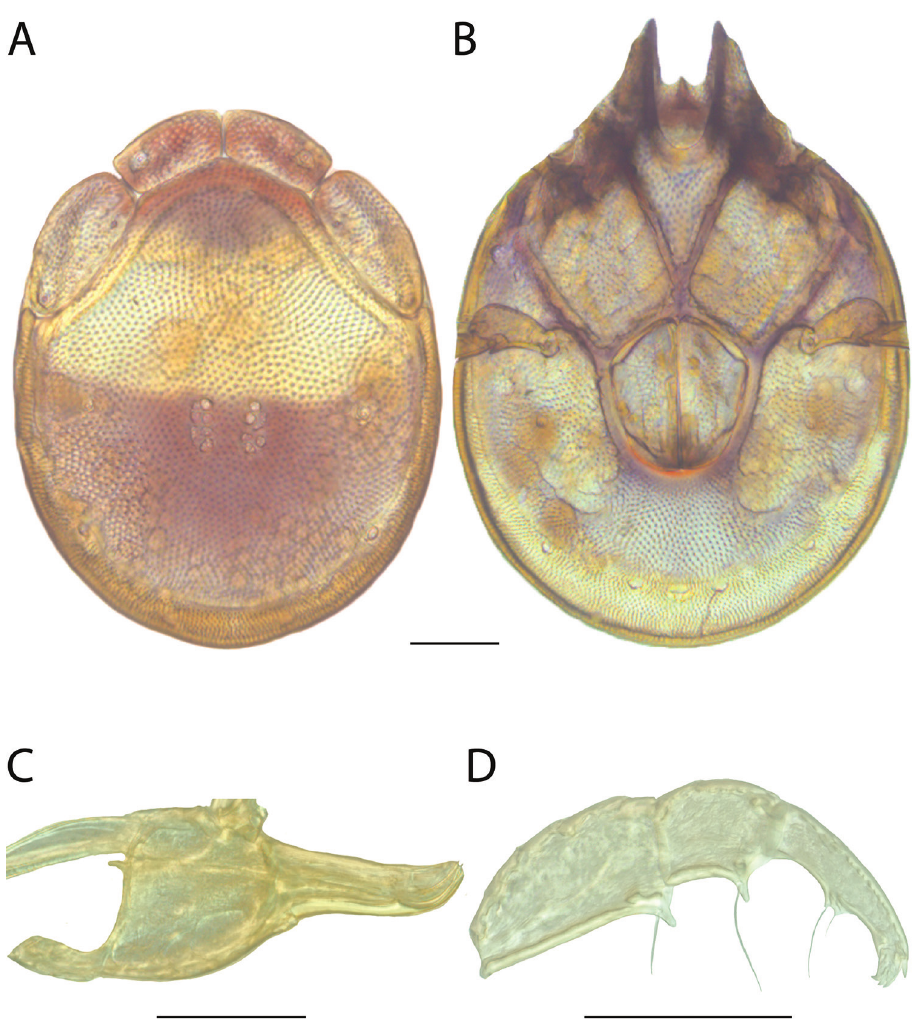
Figure 85. Torrenticola glomerabilis sp. n. female: A dorsal plates B venter (legs removed) C subcapitulum D pedipalp (setae not accurately depicted). Scale = 100